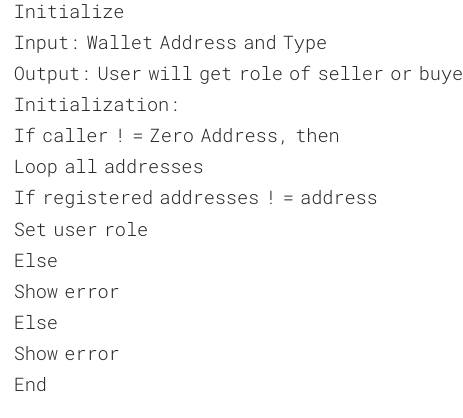
Figure 9. The algorithm is elaborated as